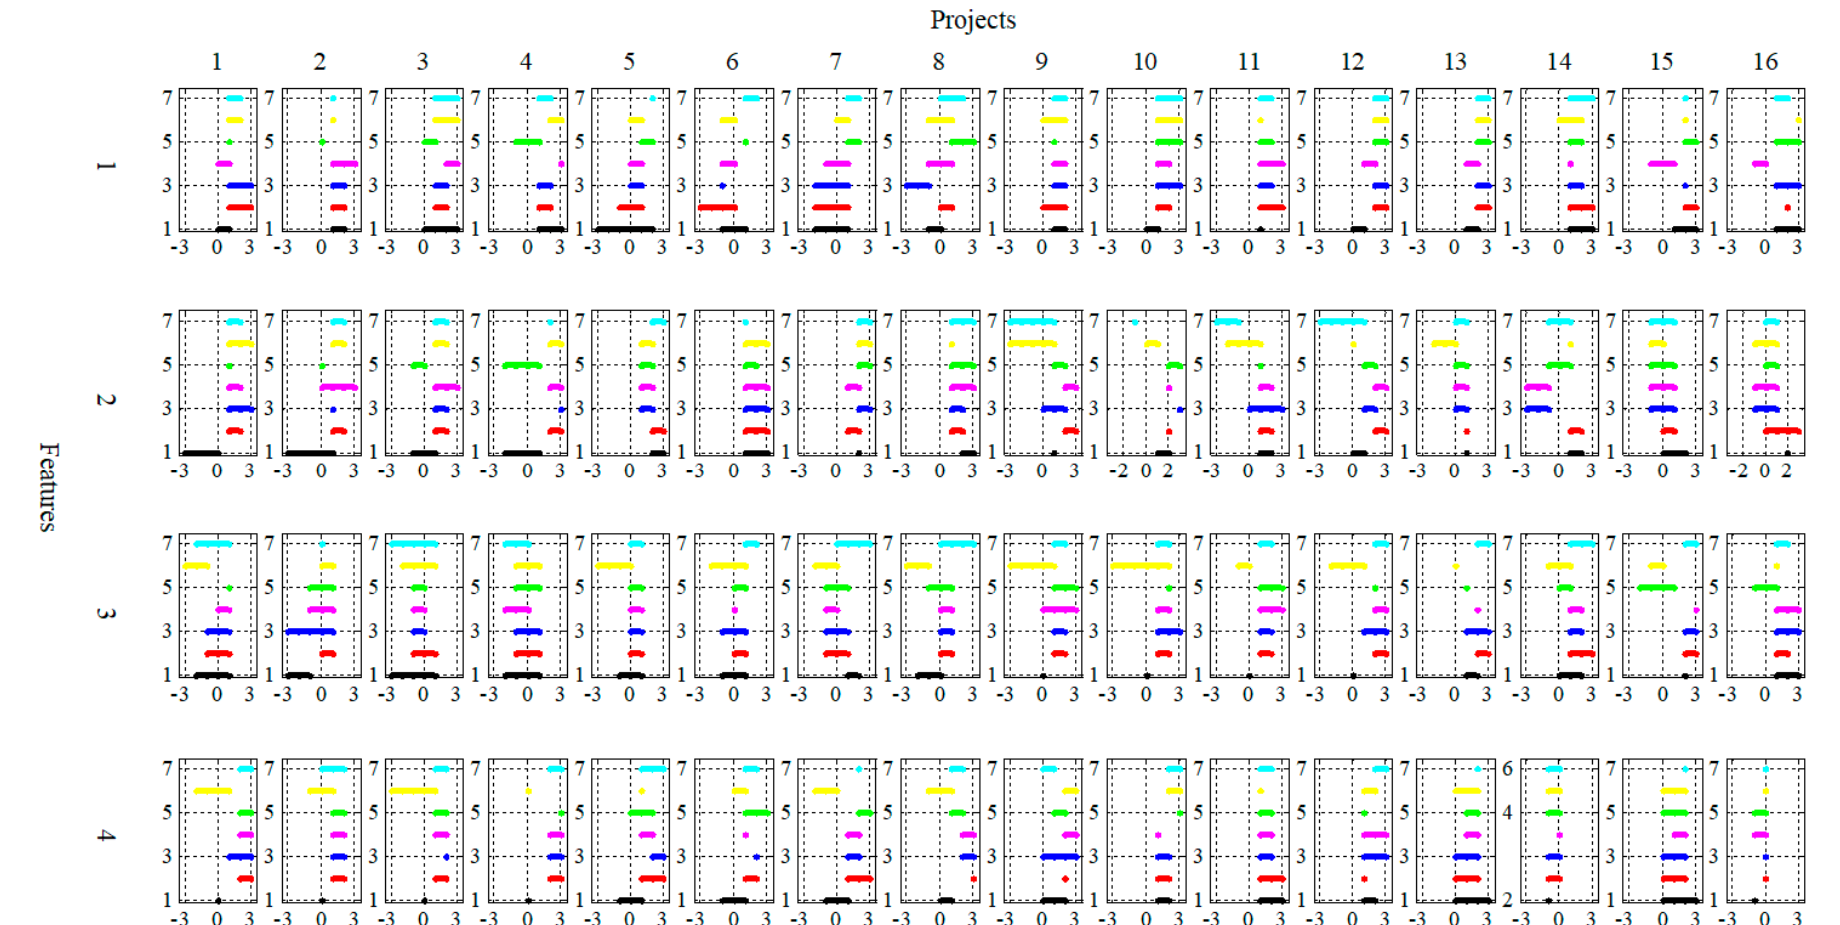
Figure 2. Interval expert assessments of 16 CPs based on 4 features.